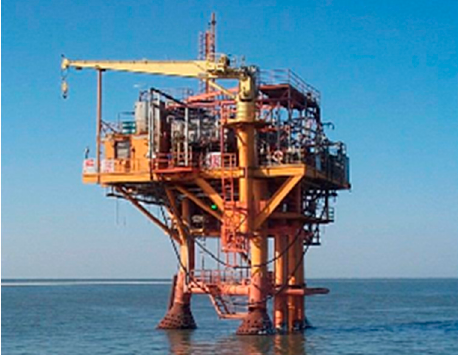
Figure 16. The ice-resistant modification of the platform.